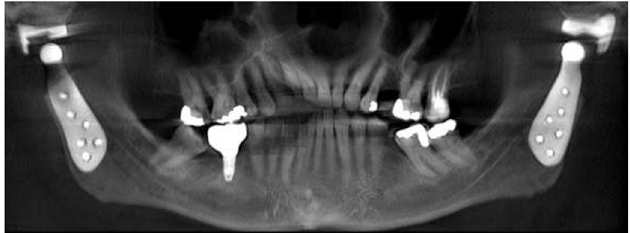
Fig. 2. Post-operative scan of bilateral custom